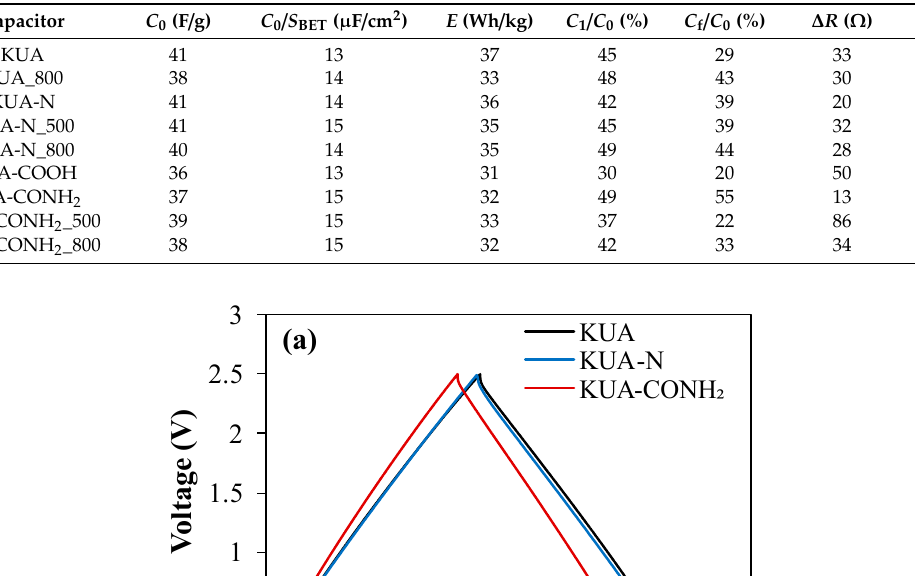
Table 4. Gravimetric capacitance, surface capacitance, energy density, retention of capacitance at